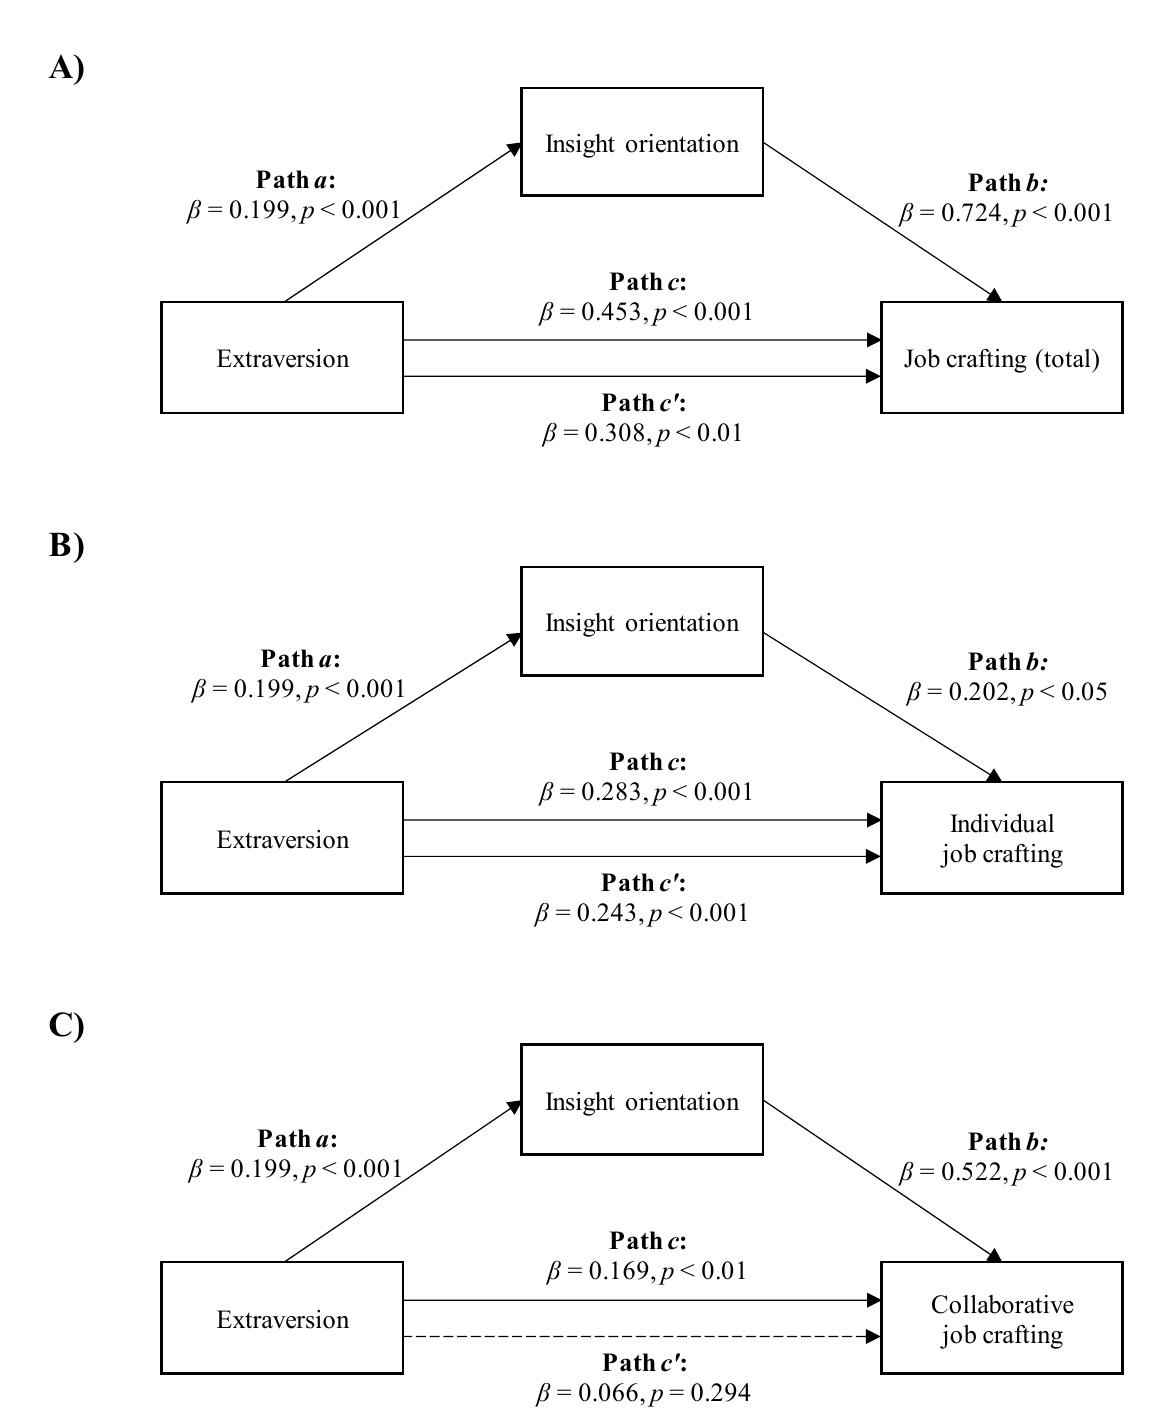
Figure 1. The mediation of insight orientation in the relationships between extraversion and total job crafting score ( A ) R 2 mediator effect size = 0.12, p < 0.01), individual job crafting, ( B ) R 2 mediator effect size = 0.06, p < 0.05) or collaborative job crafting ( C ) R 2 mediator effect size = 0.14, p < 0.01).